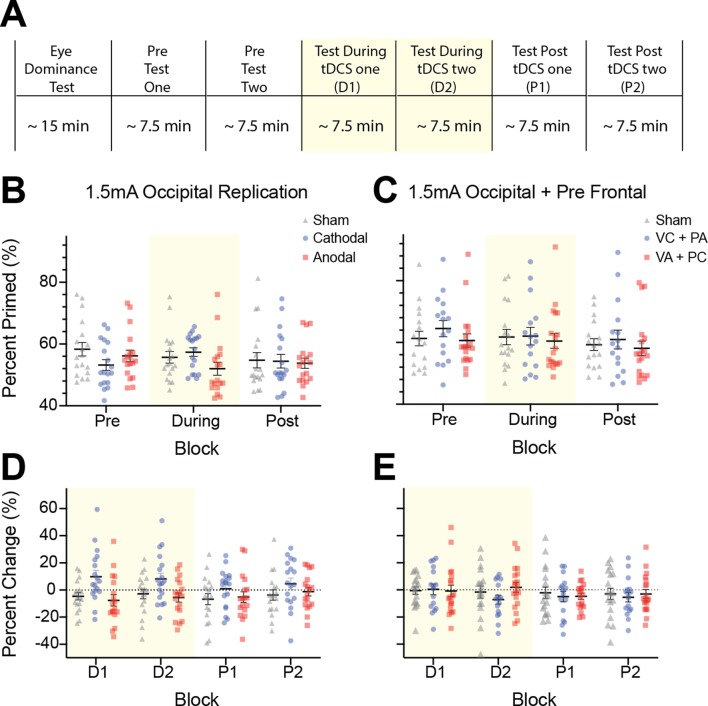
Raw tDCS imagery strength and difference scores as a function of block for experiments 3 and 5.(A) Experimental timeline for all tDCS experiments. Spread of individual data points for raw data and difference scores for experiment 3 (Occipital stimulation: B and D), experiment 5 (Occipital + Prefrontal stimulation: C and E). For B and C blue data points represent individual subjects’ cathodal stimulation changes, red data points represent anodal stimulation changes and grey data points represent sham stimulation. For D and E blue data points represent cathodal-occipital and anodal-prefrontal stimulation, while blue represents anodal-occipital and cathodal-prefrontal stimulation, and grey data points represent sham stimulation. For the raw data (B and C) the figure shows data averaged across pre, during and post-stimulation blocks. For the difference scores (percent change) data (D and E), the figure shows difference scores (percent change) for each imagery block, two during (D1 and D2, shaded yellow area) and two after tDCS (P1 and P2). All error bars show ± SEMs.